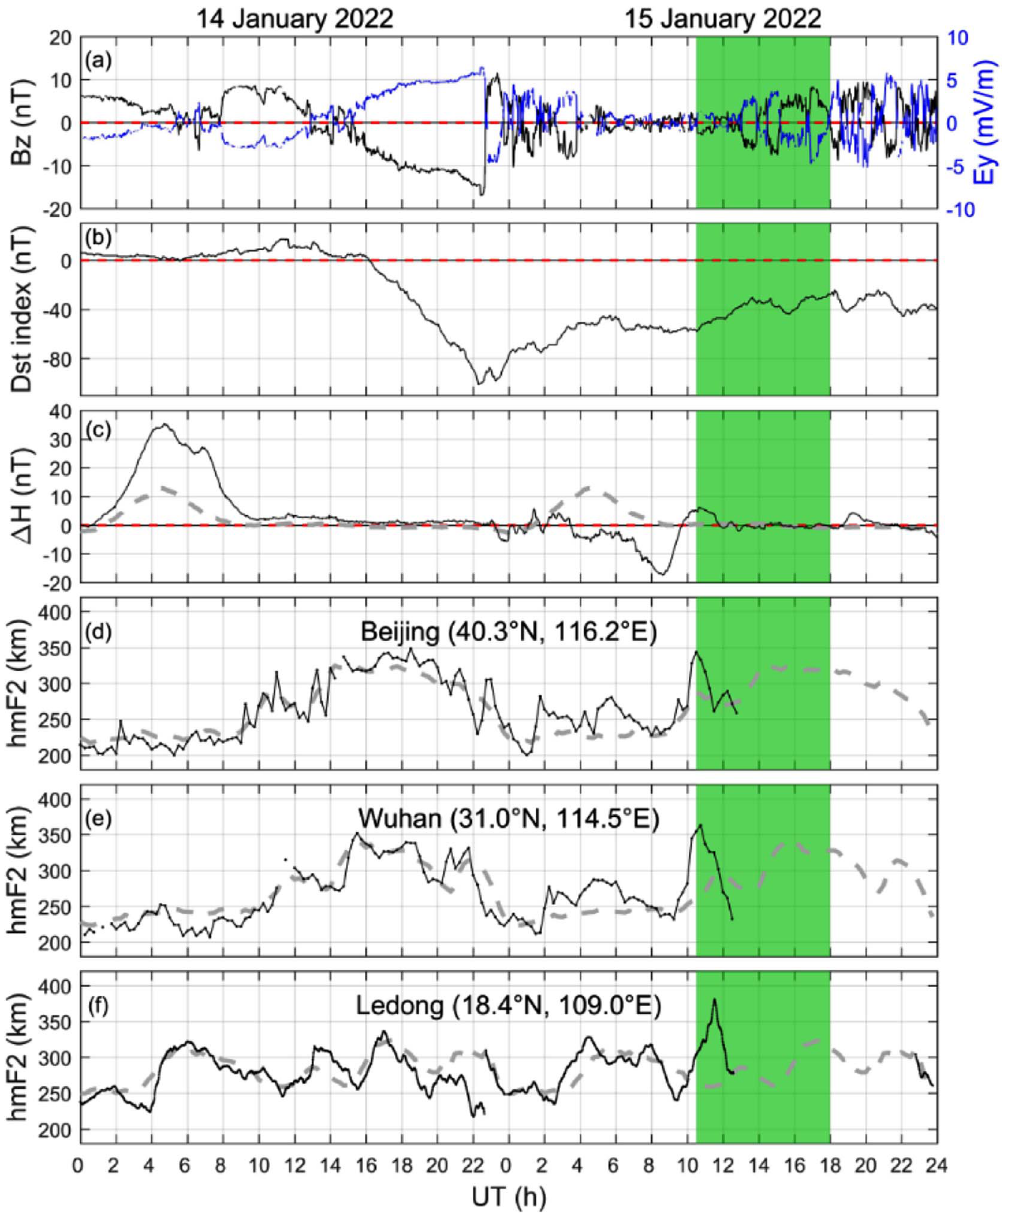
Fig. 4. The (a) IMF B z (black curve) and IEF E y (blue curve), (b) Dst , (c) D H , and h m F 2 observed at (d) Beijing, (e) Wuhan, and (f) Ledong during 14 – 15 January 2022. The green shaded areas mark the approximate period of the EPBs. The grey dashed curves represent the monthly mean values. The red horizontal dashed lines in (a) – (c) mark the value of